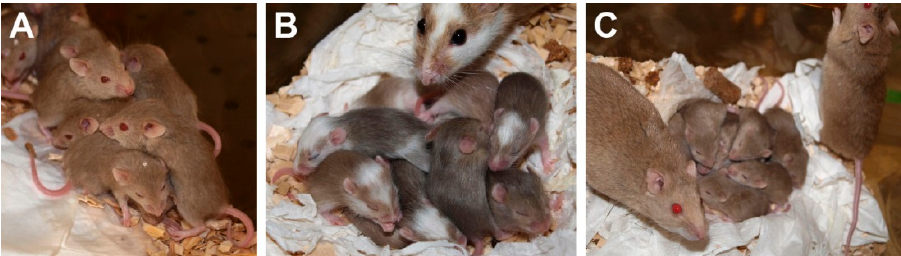
Figure 3. Young Mastomys coucha . ( A ) Young Mastomys usually huddle together. ( B , C ) Parental Mastomys , especially the mother, have a strong protective instinct and always stay close to their offspring.